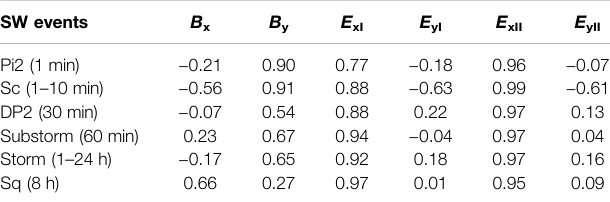
TABLE 1 | Correlation coef fi cients between the GIC and surface magnetic fi elds, B x and B y and the electric fi eld, E y and E x induced by B x and B y , respectively, calculated in one (I)- and two (II)-layer models for space weather (SW) events with periods ranging from 1min to 24 h.